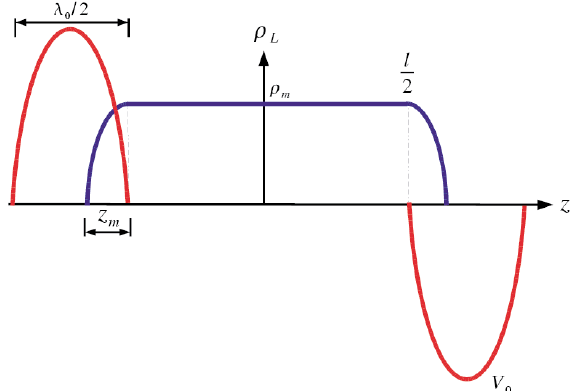
FIG. 1. (Color) Sketch of the line density (blue curve) of a matched beam confined between two sinus half waves (red curve) of amplitude V 0